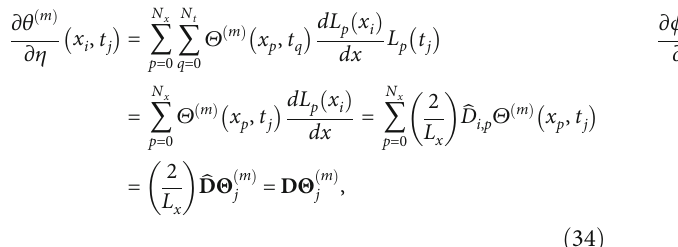
: 8, ξ = 1, N N Df = Bi = Sr = 0 : 5, He = b = t = w = 0